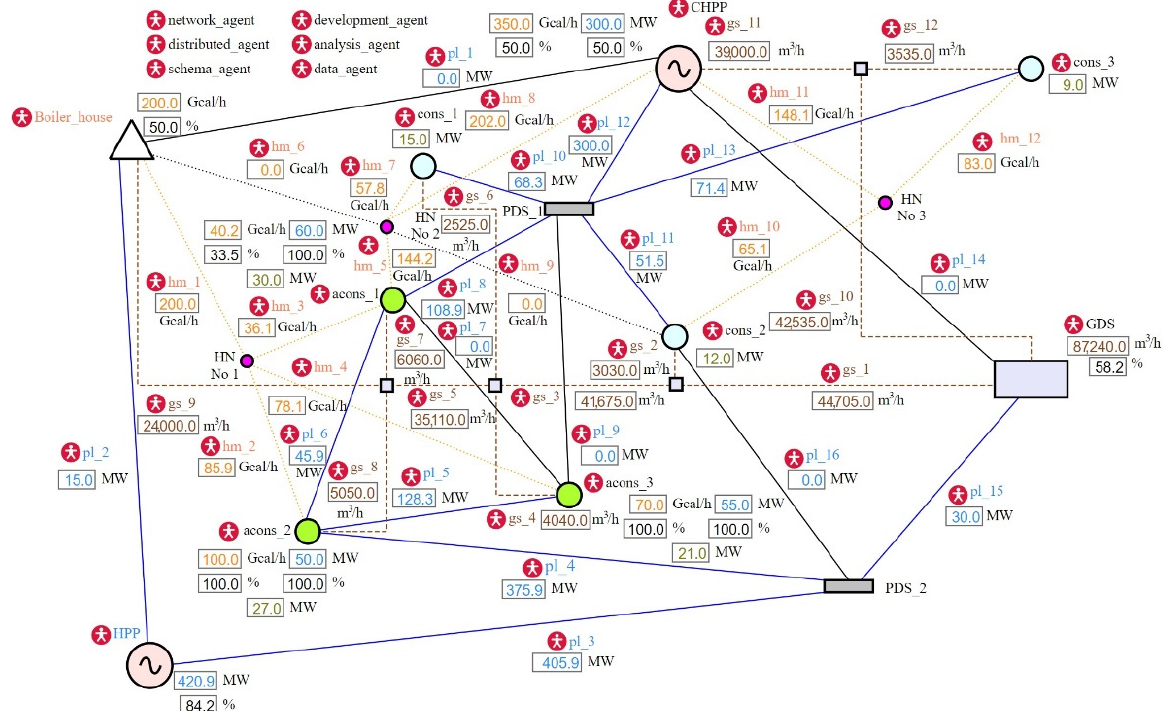
Figure 6. Results of the integrated energy system calculation. Table 1. Calculation results for energy sources.